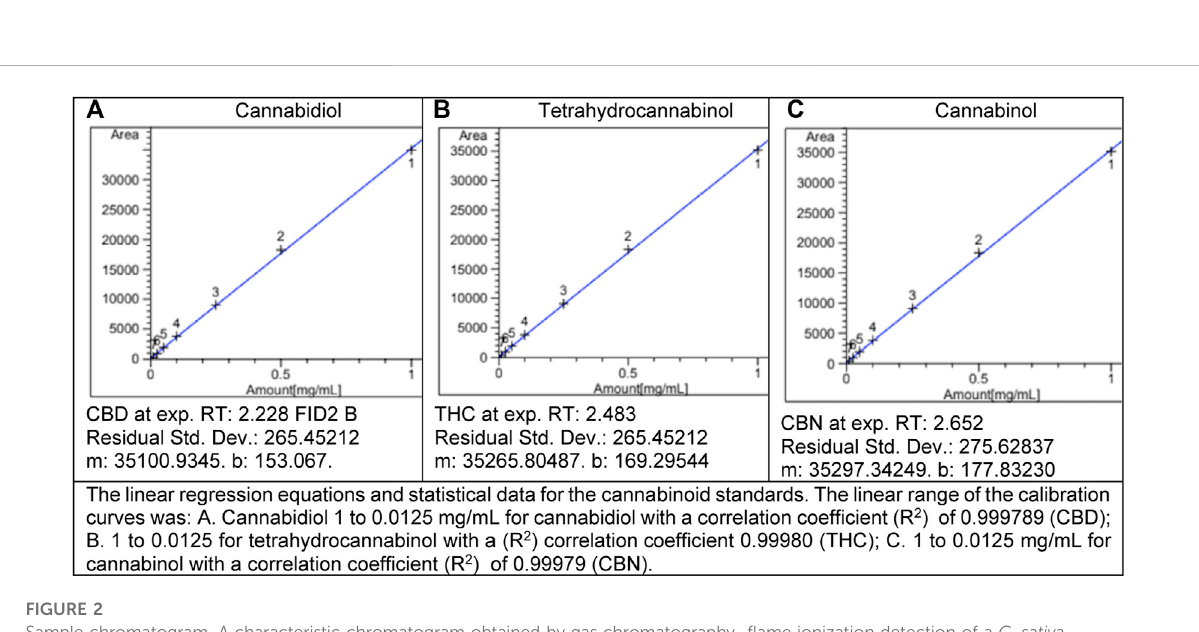
Sample chromatogram. A characteristic chromatogram obtained by gas chromatography – fl ame ionization detection of a C. sativa in fl orescence extract, chemotype CBD. The chromatogram shows a peak chromatogram of CBD at 2.223 min with a minor peak for tetrahydrocannabinol (THC) at